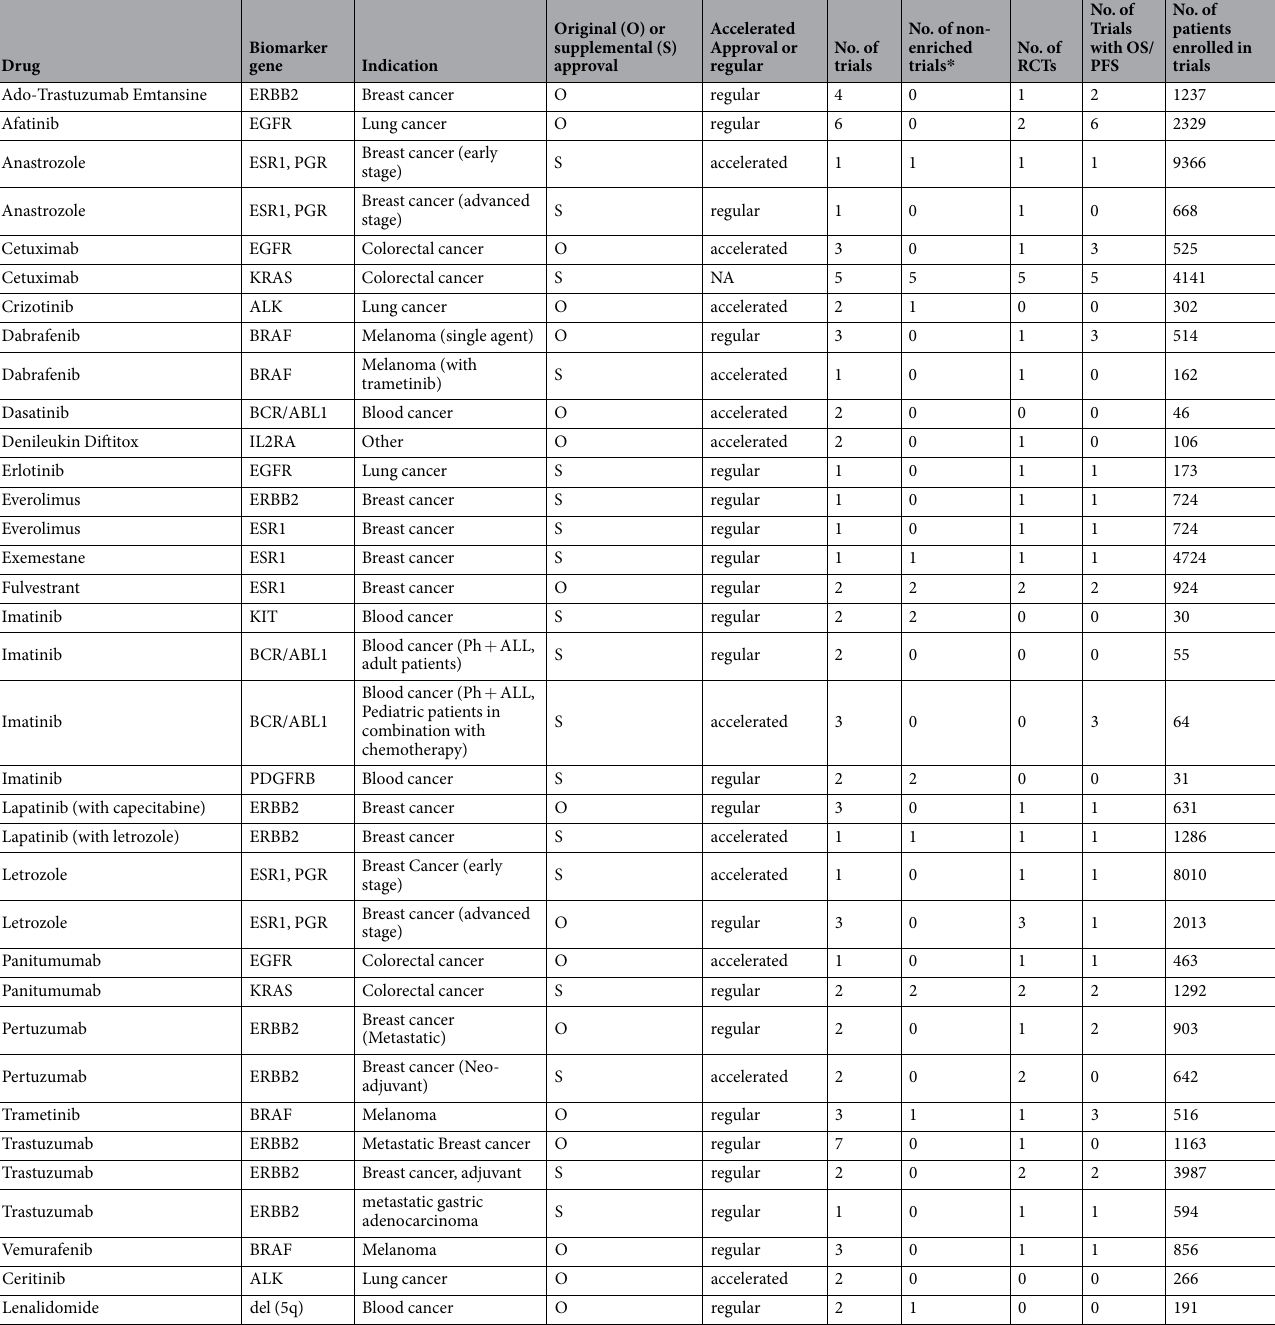
Table 1. List and Main Characteristics of Included FDA Drug Approvals (n =